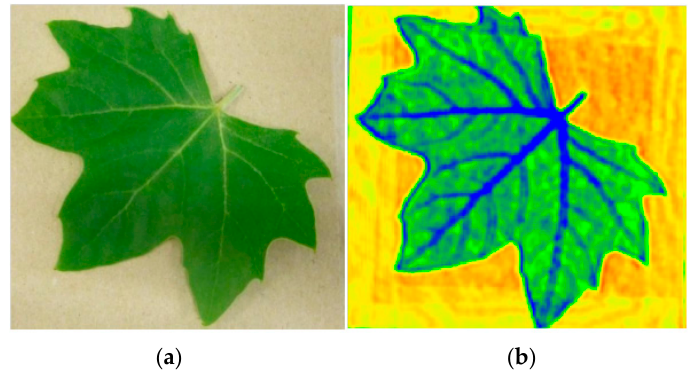
Figure 8. Photograph ( a ) and the transmission THz image ( b ) of a fresh leaf.